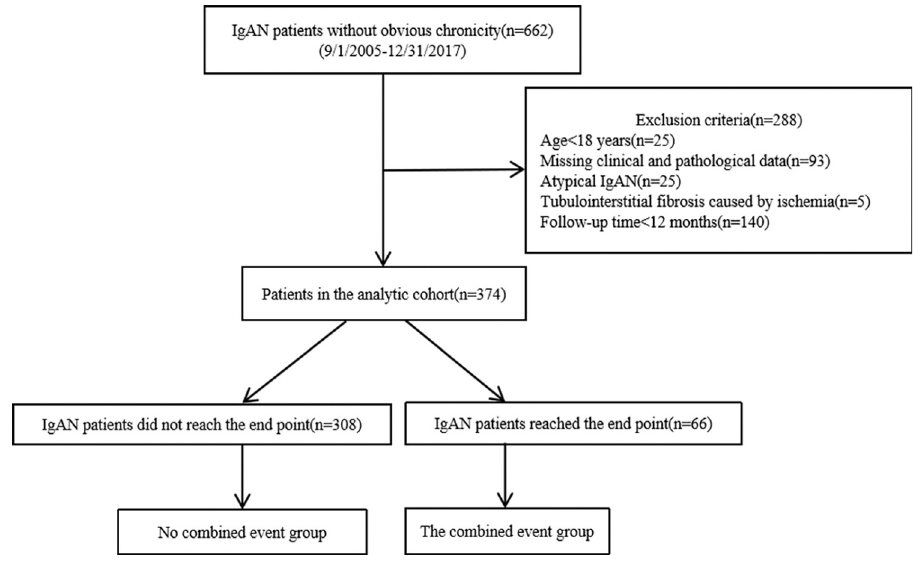
Fig 2. Enrollment of IgAN patients in our